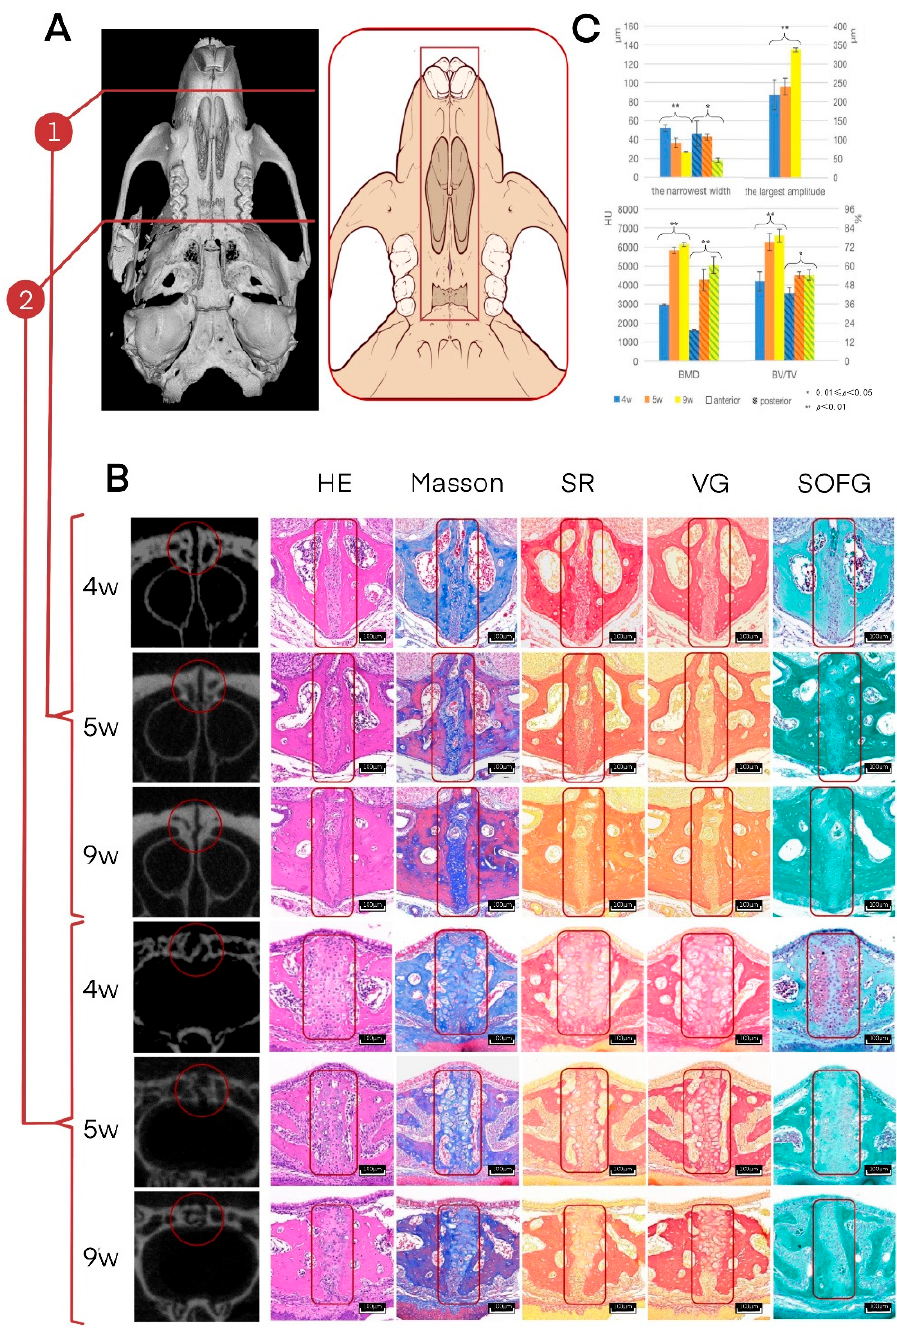
Figure 1. Histological staining and Micro-CT analysis of the midpalatal suture (mouse model). ( A ) Histological staining and Micro-CT analysis are shown at two typical sections: the anterior (the palatal plate part of the maxilla) and the posterior (the horizontal plate part of the palatal bone). ( B ) The Micro-CT coronal view, hematoxylin-eosin (HE) staining, Masson staining, Sirius red (SR) staining, Van Gieson’s (VG) staining, and Safranin O-fast green (SOFG) staining are shown in order, at 4, 5, and 9 weeks of age. Scale for Micro-CT section image: 40 × , scale for histological staining: 12 × . ( C ) Micro-CT statistical results are shown in bar charts, including the narrowest width, the largest amplitude, the bone mineral density (BMD), and the bone volume/tissue volume (BV/TV). The histological staining observation verified the Micro-CT analysis results. The mid- palatal suture region was mainly composed of fibrocytes, fibers, and osteoblasts, as is shown by the hematoxylin-eosin (HE) staining, Masson staining, Sirius red (SR) staining, and Van Gieson’s (VG) staining. Chondrocytes were observed at 4 weeks of age but were rarely seen at 5 and 9 weeks of age, as is shown by the Safranin O-fast green (SOFG)